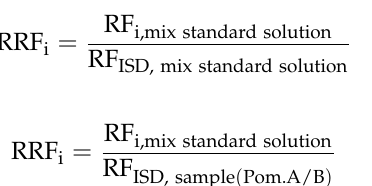
Figure 2. Pomegranate molasses (POM.A) sample chromatogram run at UV-210 nm at the following conditions: flow rate, 0.3 mL/min; column temperature, 30 °C; and run time, 20 min.